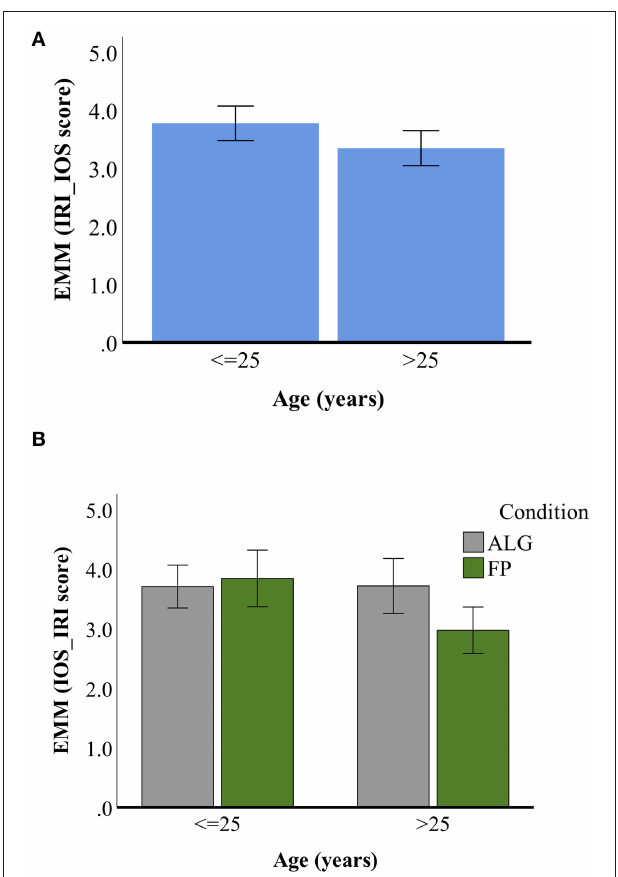
FIGURE 1 | Estimated Marginal Means (EMM) of composite IOS_IRI score (IOS_IRI score) for between-subject effects of (A) age , with EMMs for n = 43 participants < = 25 years of age and n = 47 participants > 25 years of age; (B) age * cond , gray bars denoting EMMs for participants in the ALG experimental condition and green bars for participants in the FP condition. For each panel, Error Bars correspond to 95% confidence interval.